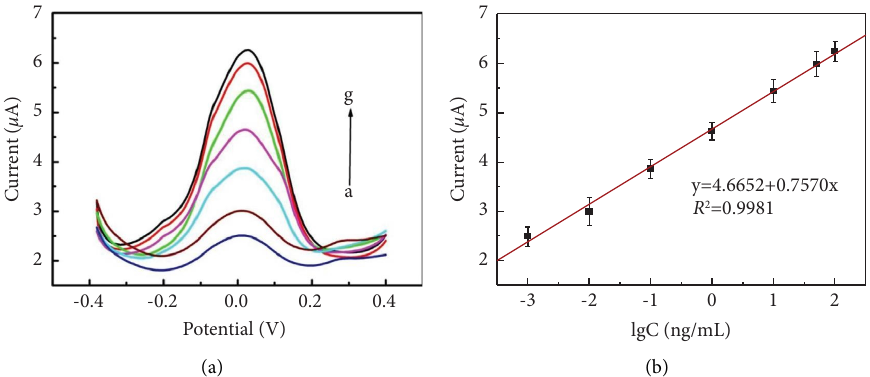
Figure 4: (a) DPV responses of the as-prepared immunosensor after incubation with CEA concentrations (From a–g: 0.001, 0.01, 0.1, 1.0, 10.0, 50.0, and 100ng · mL − 1 ) in 0.1M PBS (pH 6.5). (b) Calibration curves of the immunosensor. Error bars represent standard deviations from fve repeated